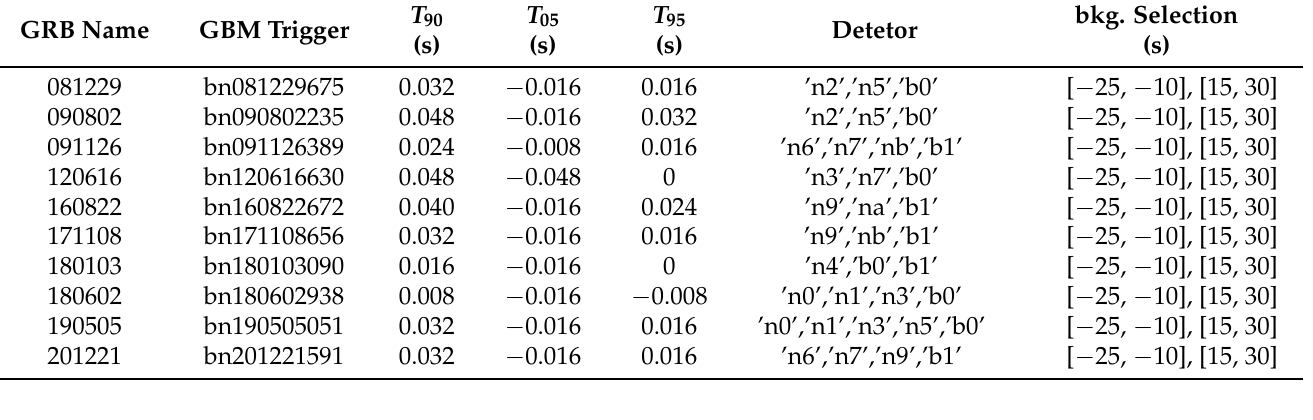
Table 1. Information of our GRB sample.